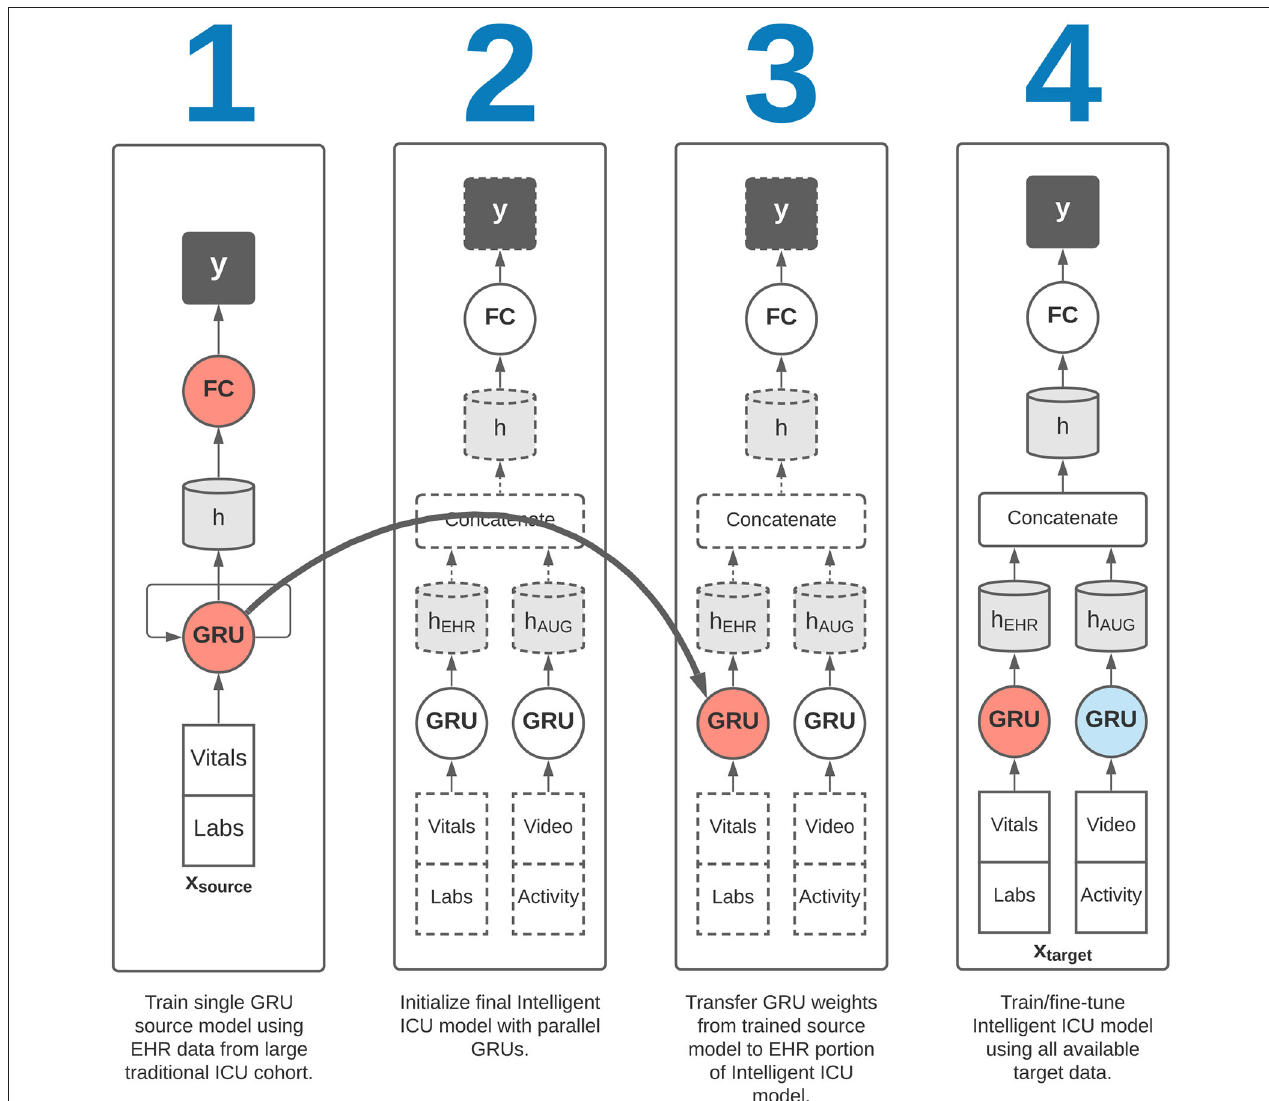
FIGURE 3 | Overview of transfer learning procedure. Our final Intelligent ICU model incorporates pre-trained representational knowledge from a source deep learning model trained only on electronic health records data from a large cohort of traditional ICU stays ( n = 48,400).